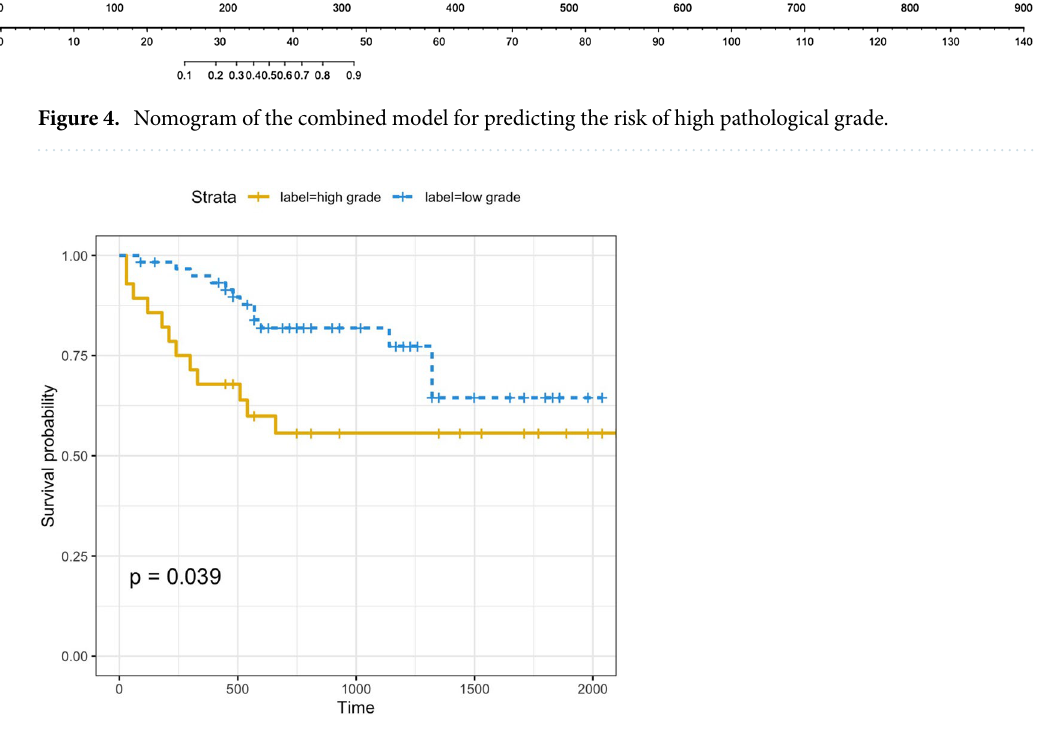
Figure 5. Decision curves of the combined clinical, radiomics, and clinical-radiomics models for predicting pathological